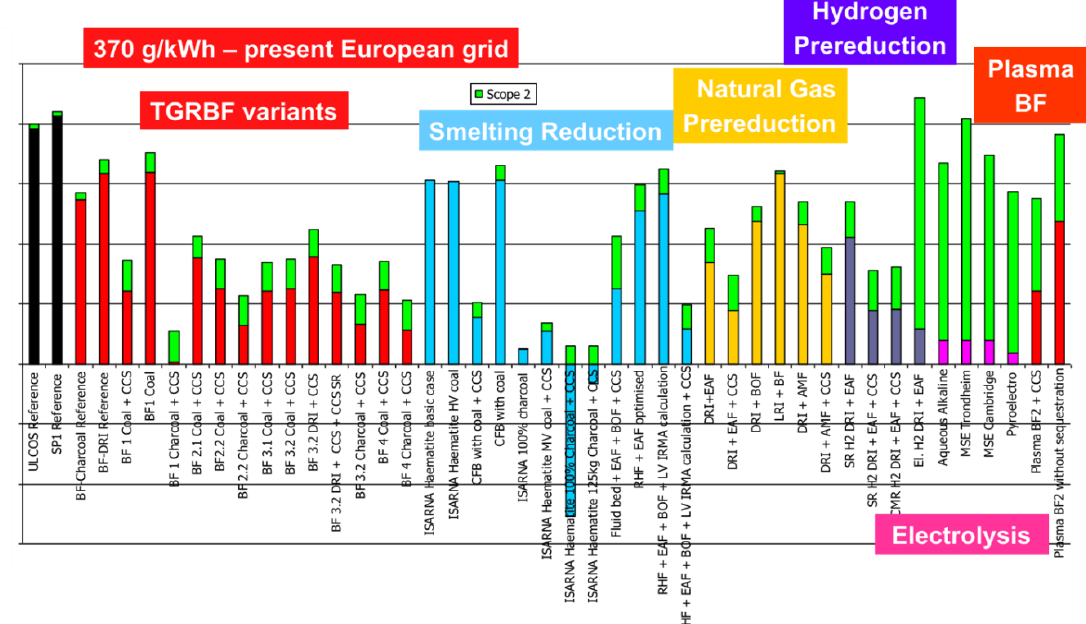
Figure 19. CO 2 specific emissions (t CO2 /t HRC ) for a 370 g/kWh grid.